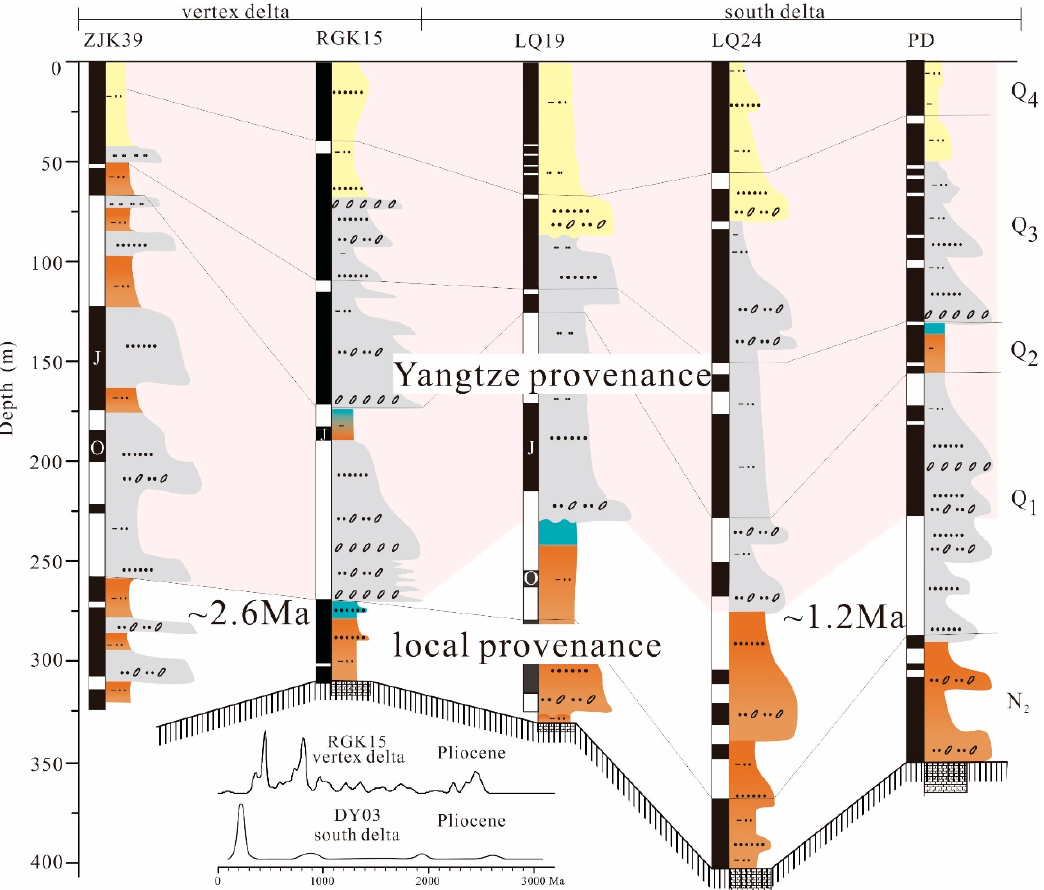
Figure 6. Regional chronostratigraphy and provenance evolution across the modern Yangtze delta section. The pink highlight denotes Yangtze-derived provenance. For lithology legends, see Figure 2. For core locations, see Figure 1. The relevant information on the chronology, lithology and provenance of the cores is cited from ZJK39 [26], LQ19 [39], LQ24 [15] and PD [13]. The inset figure in the lower-left corner shows zircon age spectra of the Pliocene sediments in core RGK15 of vertex delta (this study) and core DY03 of south delta [12].